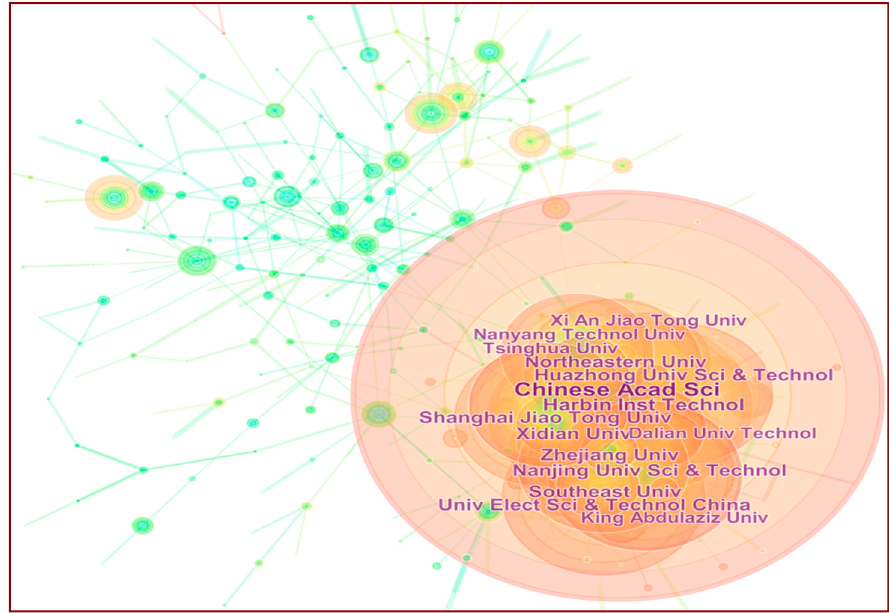
Figure 6. Institution Co-Citation Analysis. Table 5. Most Productive and Influential Institutions in NC